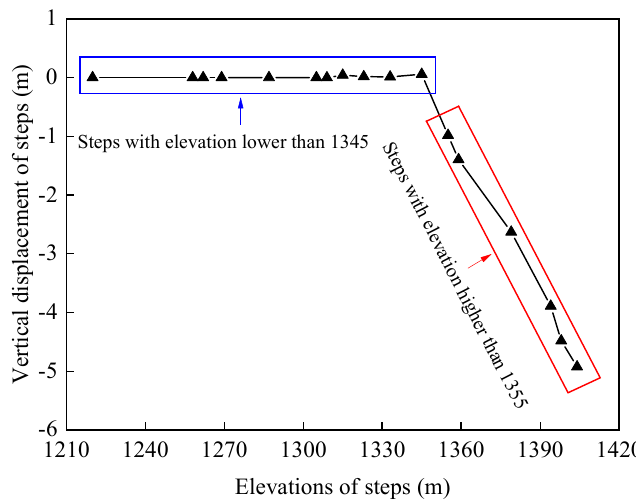
Figure 11. Maximum subsidence value of steps at an advancing distance of 240 m.